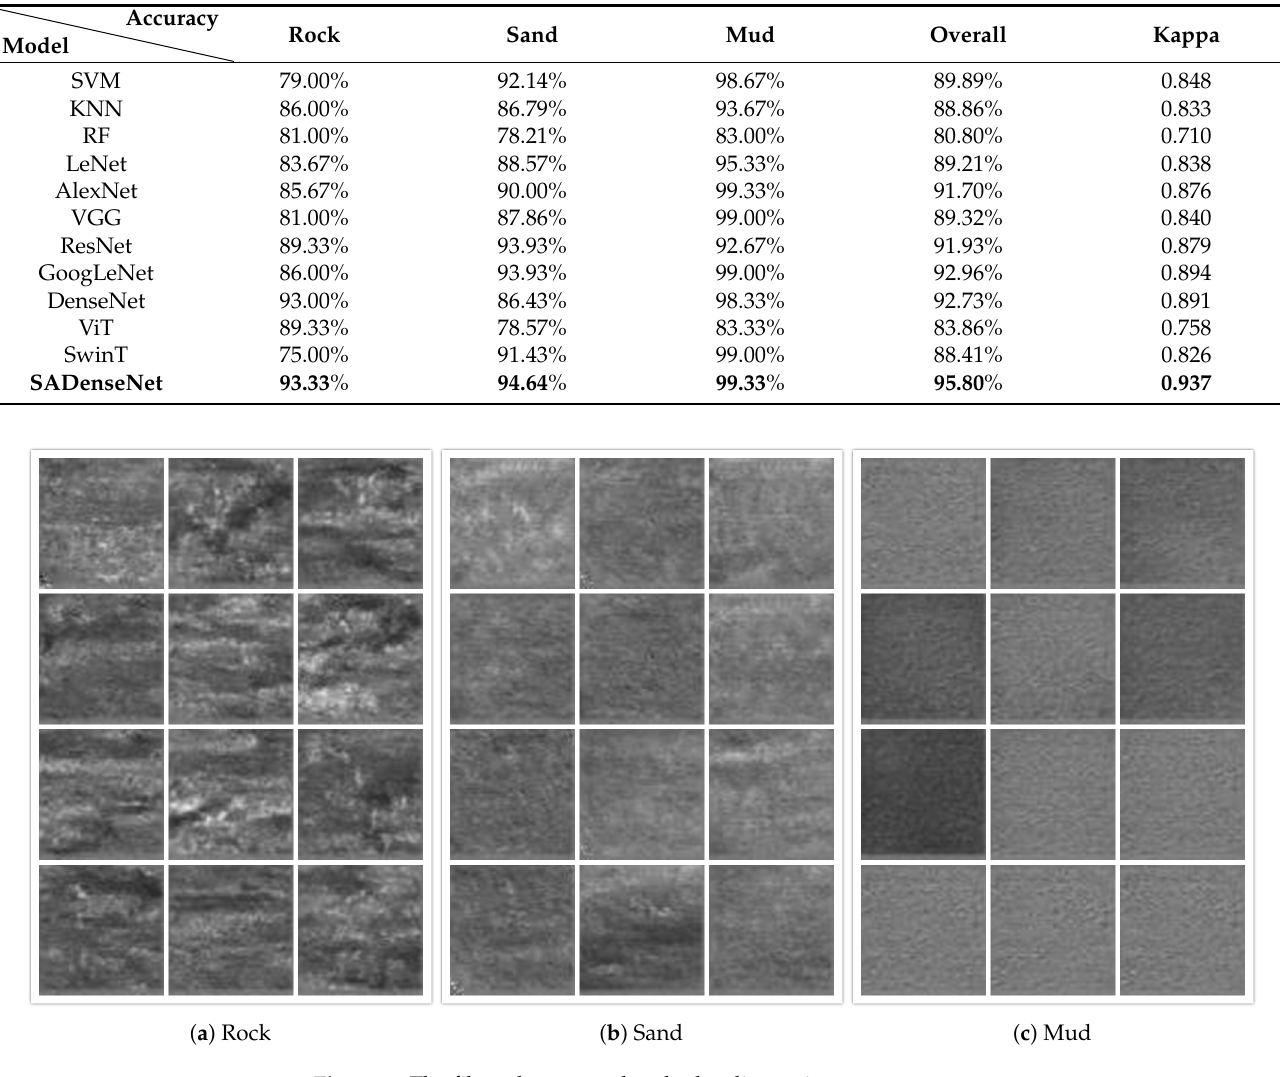
Figure 8. The filtered generated seabed sediment